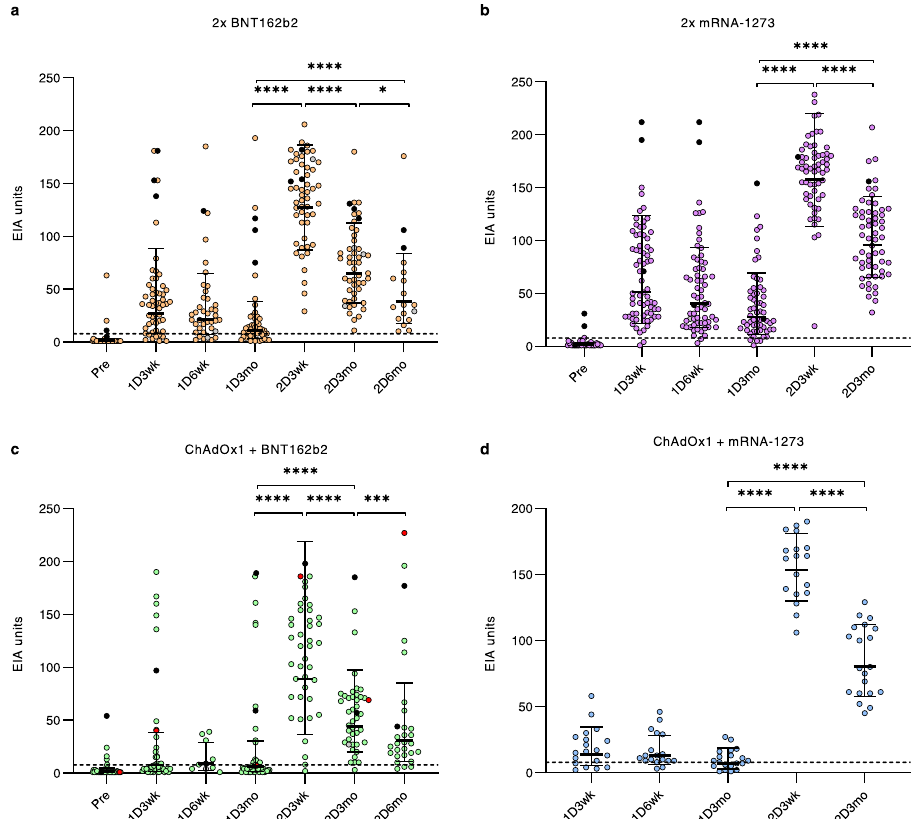
Fig. 2 Antibody responses of HCWs after receiving one and two doses of COVID-19 vaccines with a long vaccine dose interval. SARS-CoV-2 S1-speci fi c IgG antibody levels were measured with EIA in all vaccine combination groups ( a 2x BNT162b2, b 2x mRNA-1273, c ChAdOx1 + BNT162b2, d ChAdOx1 + mRNA-1273) from sera collected before vaccination (Pre), three weeks (1D3wk), six weeks (1D6wk) and twelve weeks (1D12wk) after the fi rst vaccine dose (1D), and three weeks (2D3wk), three months (2D3mo), and six months (2D6mo) after the second vaccine dose (2D). The number of samples in each timepoint is presented in Supplementary Table 1. Eight HCWs with PCR con fi rmed SARS-CoV-2 infection prior to vaccinations are represented with black dots and one HCW with a breakthrough infection (>20 EIA unit increase between samples) after the second vaccine dose is represented with red dots. Geometric mean with geometric SD is represented in fi gures. Statistical differences between samples collected before vaccination vs. three weeks after the fi rst vaccine dose, between samples collected three vs. twelve weeks after the fi rst dose, between samples collected twelve weeks after the fi rst dose vs. three weeks after the second dose, and between samples collected three weeks after both vaccine doses, were analyzed with two-sided Wilcoxon signed-rank test. P-values <0.05 were considered statistically signi fi cant. P -values: <0.0001 marked with ****, 0.0007 with *** and 0.0118 with *, ns indicates not signi fi cant. Cut-off values are indicated with dashed